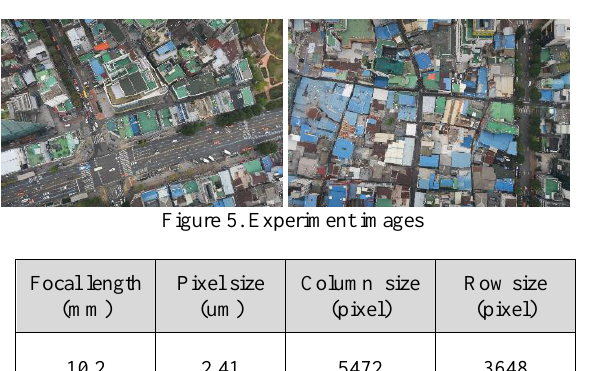
Figure 4. Target area and flight path